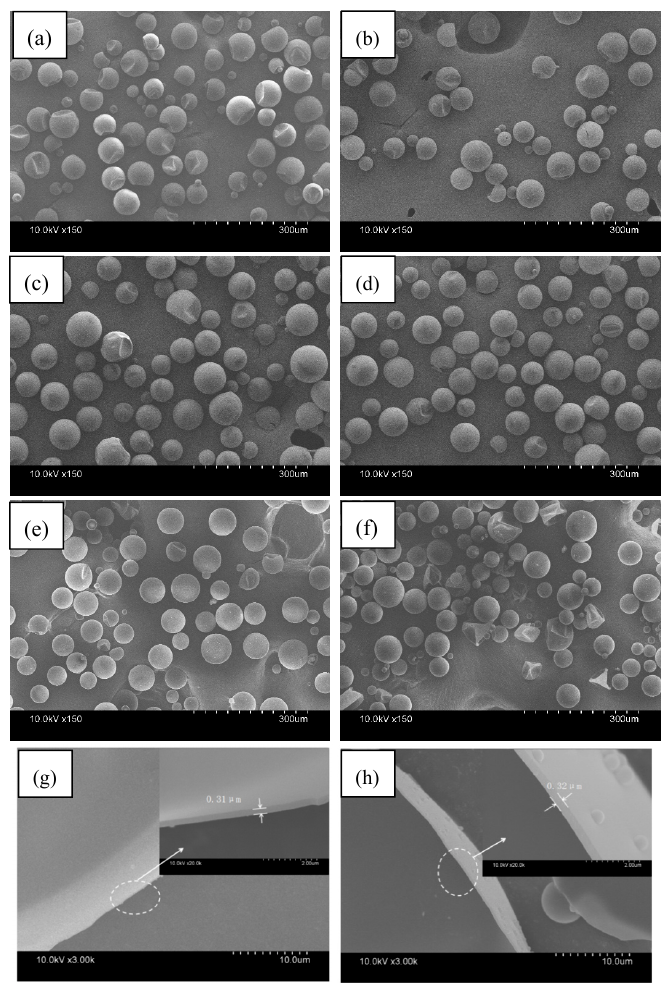
Figure 4. Scanning electron microscopy images of phase-change microcapsules (microPCMs) and damaged microPCMs with different amounts of diatomite added: ( a – g ) S0, ( b ) S1, ( c ) S2, ( d ) S3, ( e – h ) S4, and ( f ) S5.